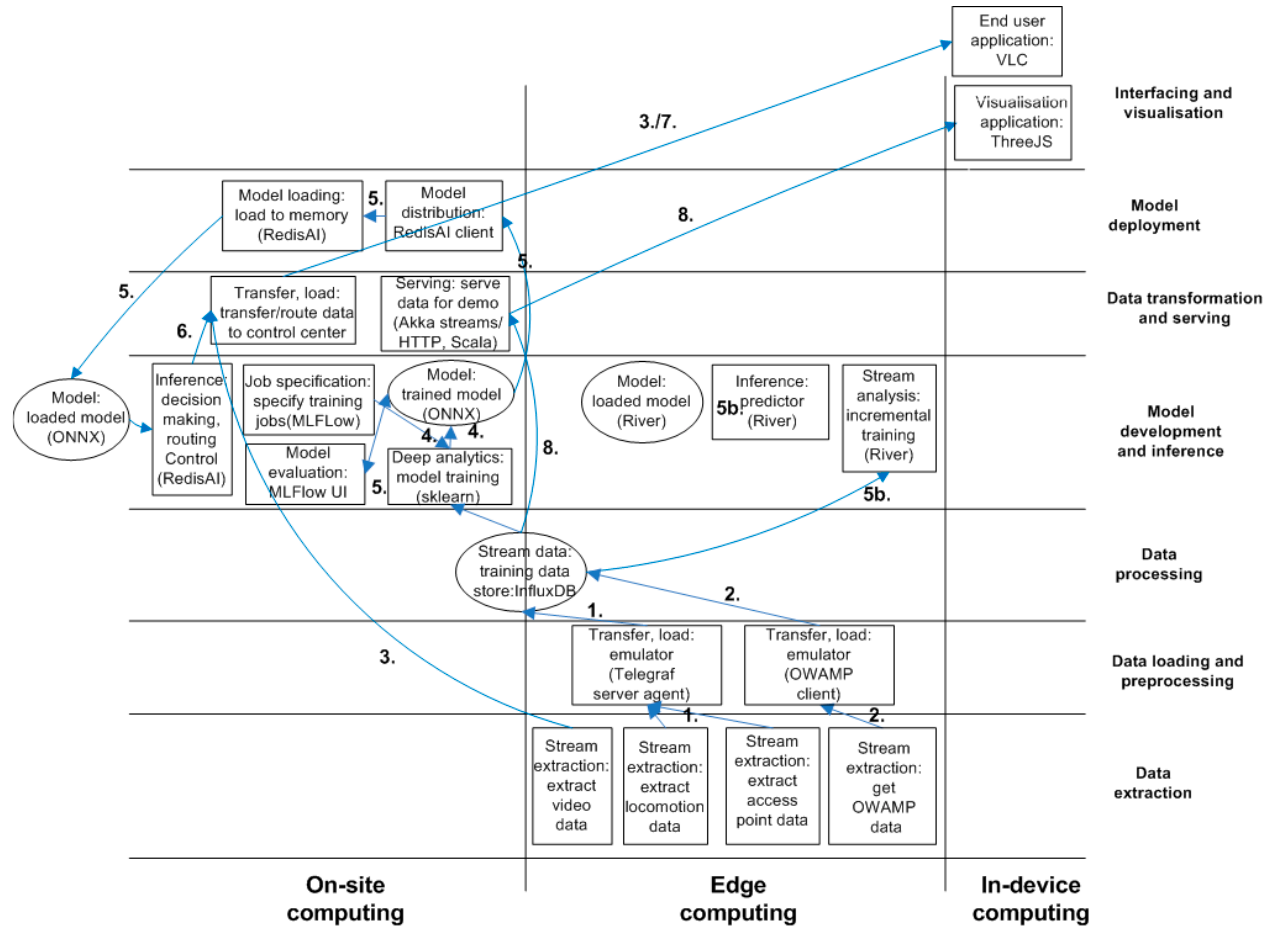
Figure 5. Deployment environment view of the system. X-axis represents deployment environments. Y-axis represents functional areas/processing pipeline of a big data system.